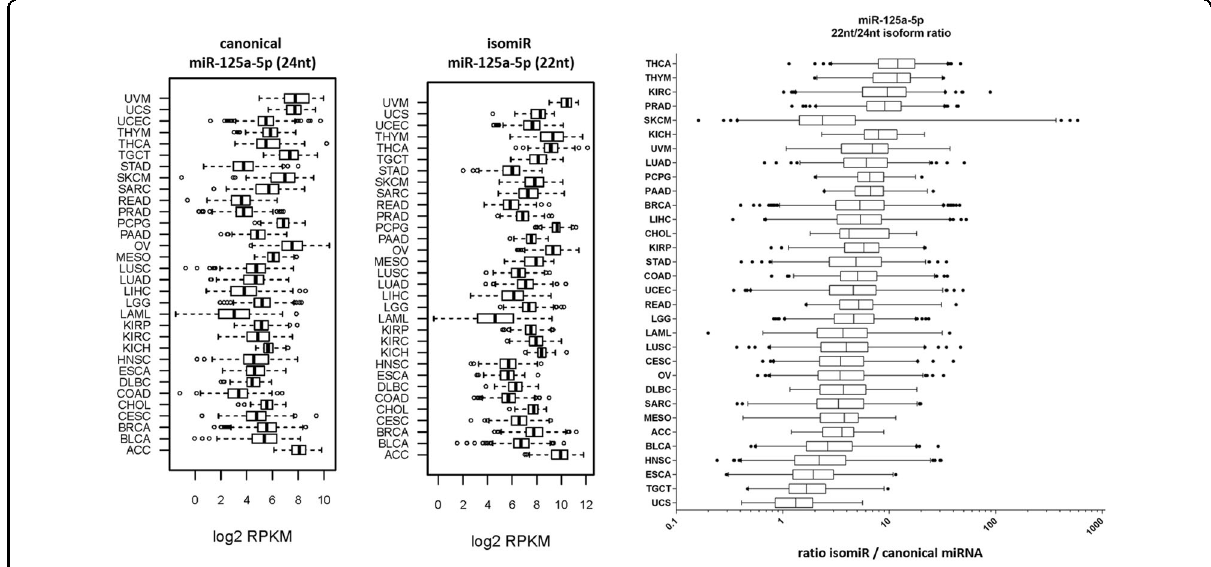
Fig. 6 Canonical hsa-miR-125a-5p|0|0) and hsa-miR-125a-5p|0| − 2 isomiR expression across 32 TCGA tumor types. miR-125a isomiR is most expressed in many cancer types. Box and whiskers graphs of canonical and shorter isoform of miR-125a-5p show variable expression levels, represented here as log2 RPKM data, across 32 different cancer type. miR-125a-5p isoform is most abundant in many cancer types and shows a speci fi cally high canonical/isoform ratio in the melanoma (SKCM) group. The bar shows 1 – 99 percentile values. TCGA abbreviations: ACC, adrenocortical carcinoma; BLCA, bladder urothelial carcinoma; BRCA, breast invasive carcinoma; CESC, cervical squamous cell carcinoma and endocervical adenocarcinoma; CHOL, cholangiocarcinoma; COAD, colon adenocarcinoma; DLBC, lymphoid neoplasm diffuse large B-cell lymphom; ESCA, esophageal carcinoma; HNSC, head and neck squamous cell carcinoma; KICH, kidney chromophobe; KIRC, kidney renal clear cell carcinoma; KIRP, kidney renal papillary cell carcinoma; LAML, acute myeloid leukemia; LGG, brain lower grade glioma; LIHC, liver hepatocellular carcinoma; LUAD, lung adenocarcinoma; LUSC, lung squamous cell carcinoma; MESO, mesothelioma; OV, ovarian serous cystadenocarcinoma; PAAD, pancreatic adenocarcinoma; PCPG, pheochromocytoma and paraganglioma; PRAD, prostate adenocarcinoma; READ, rectum adenocarcinoma; SARC, sarcoma; SKCM, skin cutaneous melanoma; STAD, stomach adenocarcinoma; TGCT, testicular germ cell tumors; THCA, thyroid carcinoma; THYM, thymoma; UCEC, uterine corpus endometrial carcinoma; UCS, uterine carcinosarcoma; UVM, uveal